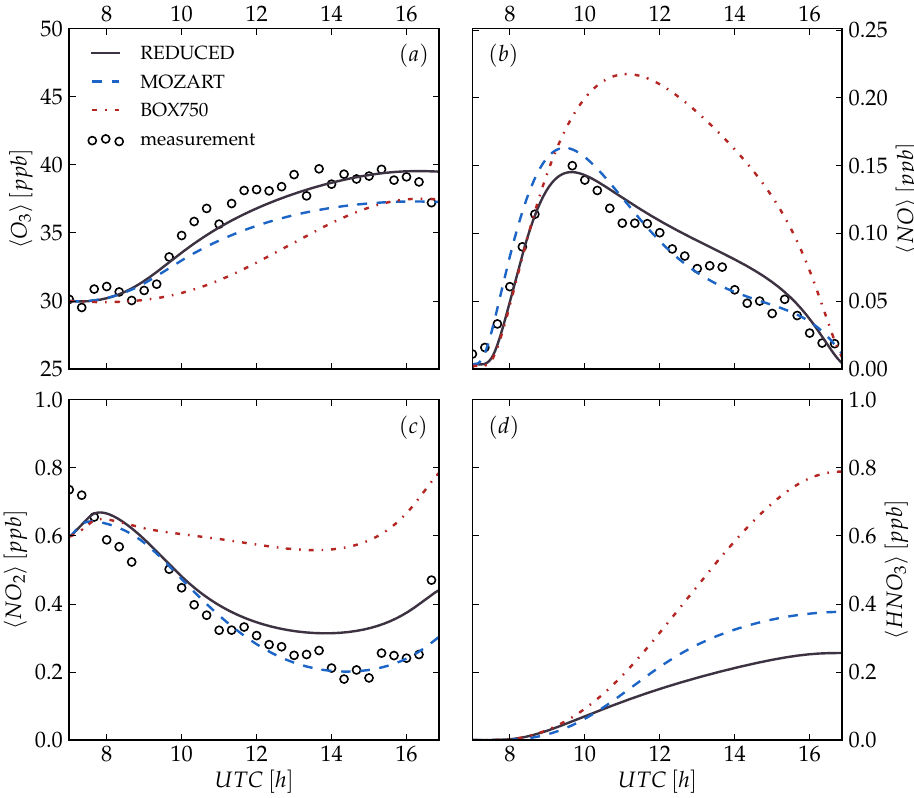
Fig. 4. Measured and modeled mixed-layer mixing ratios of O 3 , NO, NO 2 and HNO 3 as measured and modeled with MXLCH (using both MOZART and the reduced chemical scheme) and the box model (using the reduced chemistry